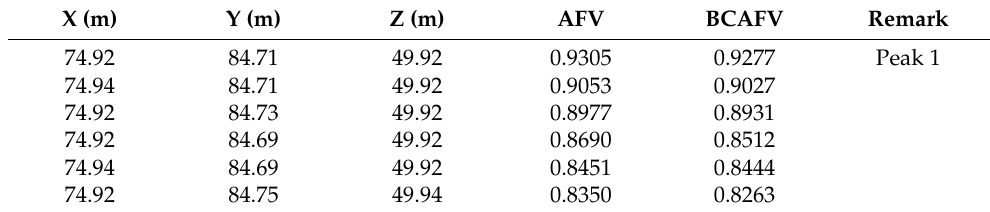
Table 6. Several large AFVs and BCAFVs and corresponding coordinates in epoch 03:03:37. X (m) Y (m) Z (m) AFV BCAFV